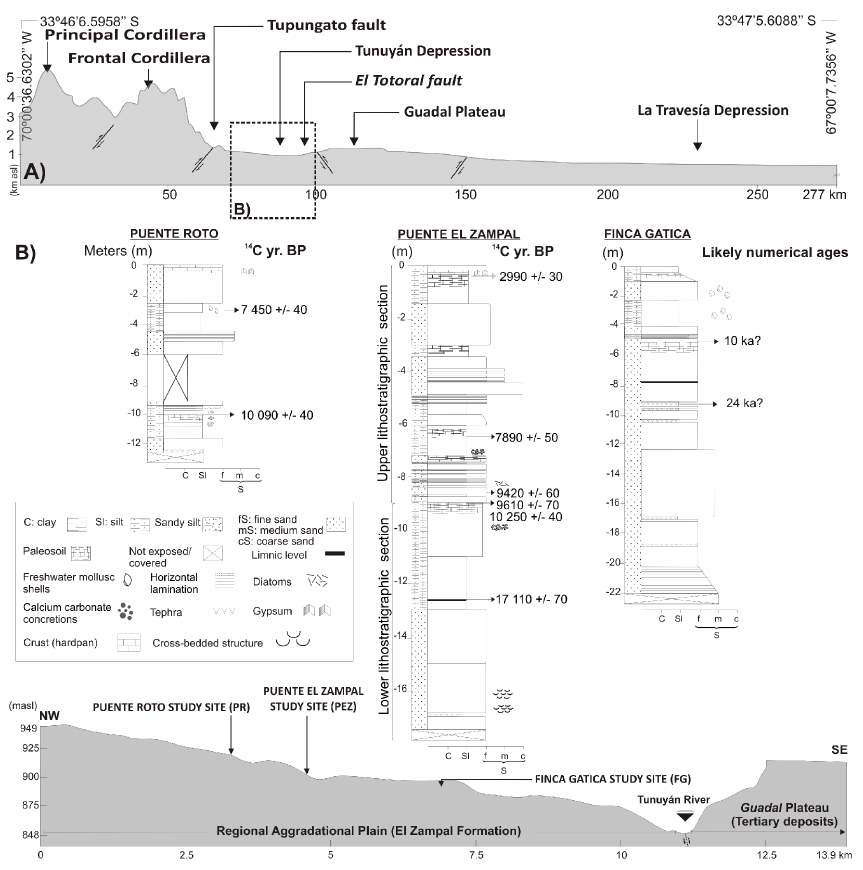
Fig. 3. (A) Sketch showing the main morphostructural units at the study area (vertical scale is exaggerated). Tunuyán Depression study area is boxed. (B) Schematic topographic profile (adapted from Google Earth software) along the regional aggradational plain in the vicinities of the arroyos Anchayuyo and La Estacada riverbanks. Lithostratigraphic field logs at each study site are